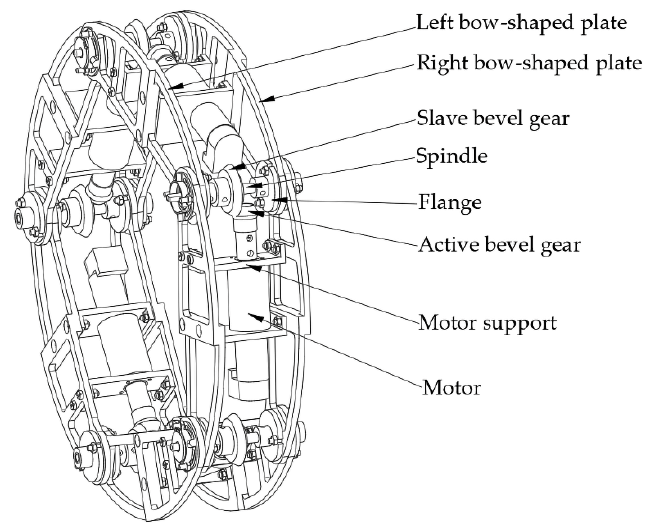
Figure 1. Mechanical structure of the rolling